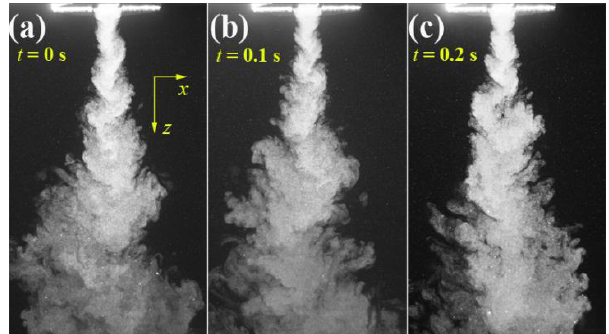
Figure 4. The visualized airflows in the x-z plane at different time instants of ( a ) t = 0 s, ( b ) t = 0.1 s, and ( c ) t = 0.2 s. The real size for each sub-image is 141.8 mm × 83.5 mm.